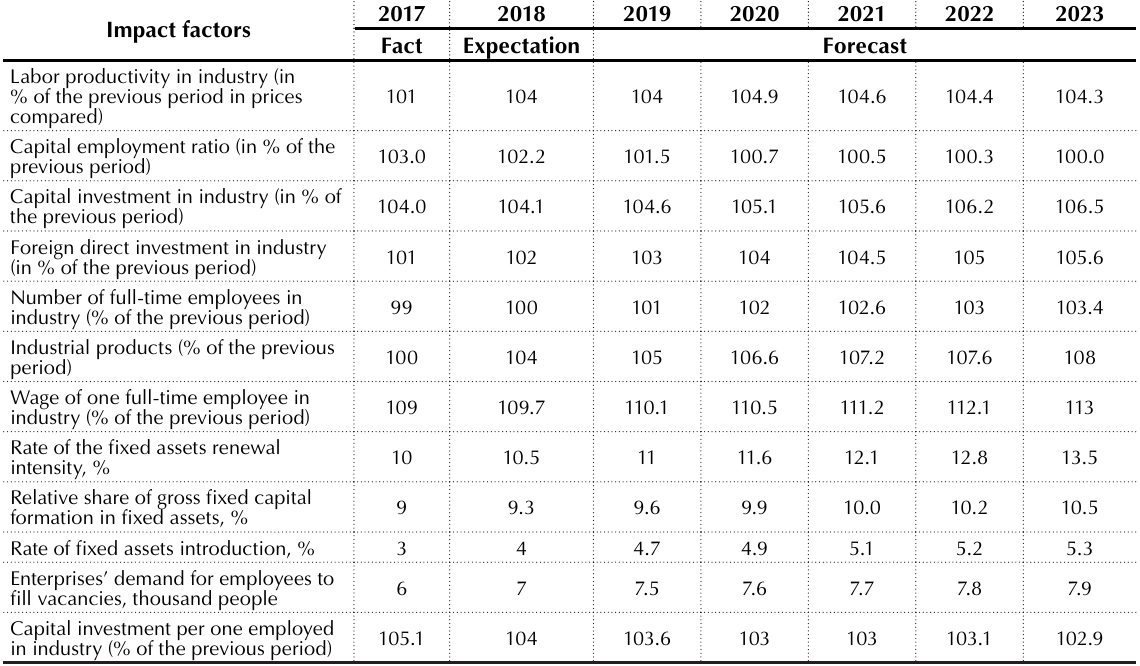
Table 4. Forecasting factors for calculating the number of new workplaces in industry (as a whole) in 2019–2023